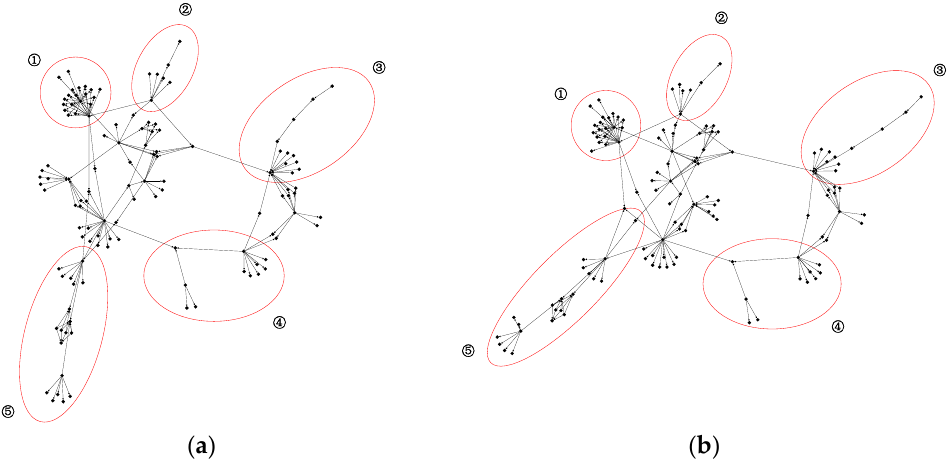
Figure 9. Comparison of function call graph structure of two malicious apps in SndApp family. Figure 9. Similarity of function call graph structure of two malicious apps in SndApp family.